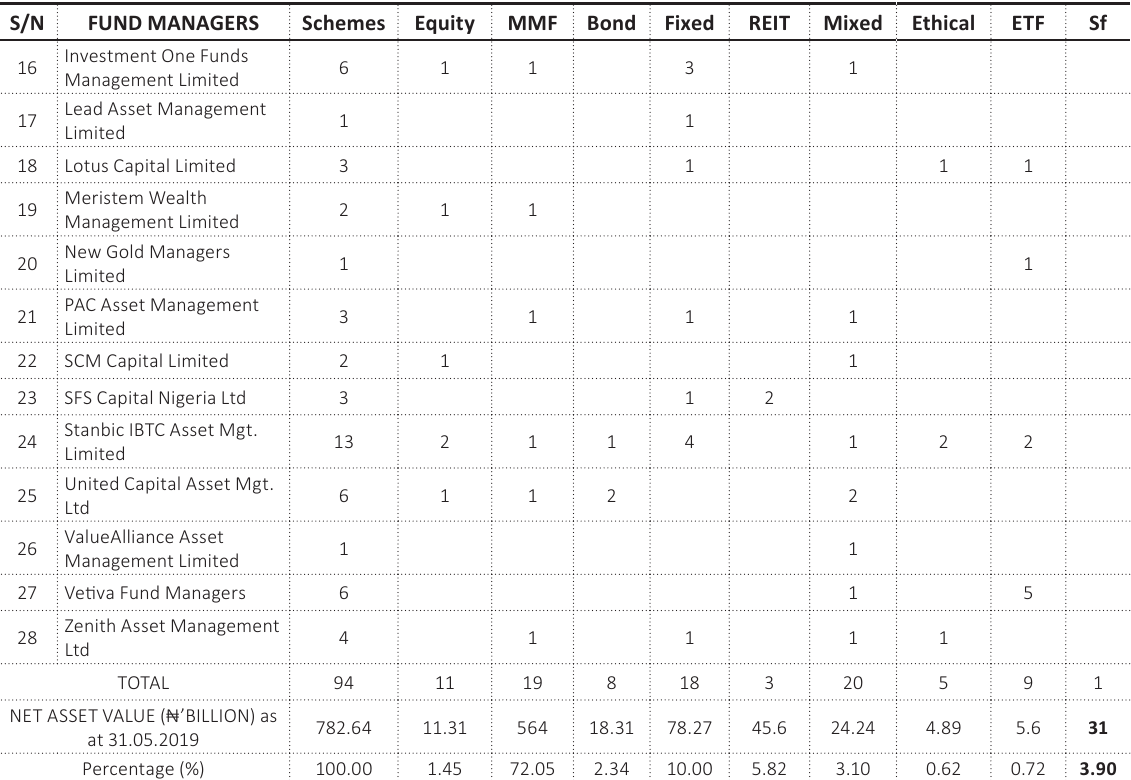
Table 1 (cont.). Fund managers, schemes, and net asset value as at May 31,